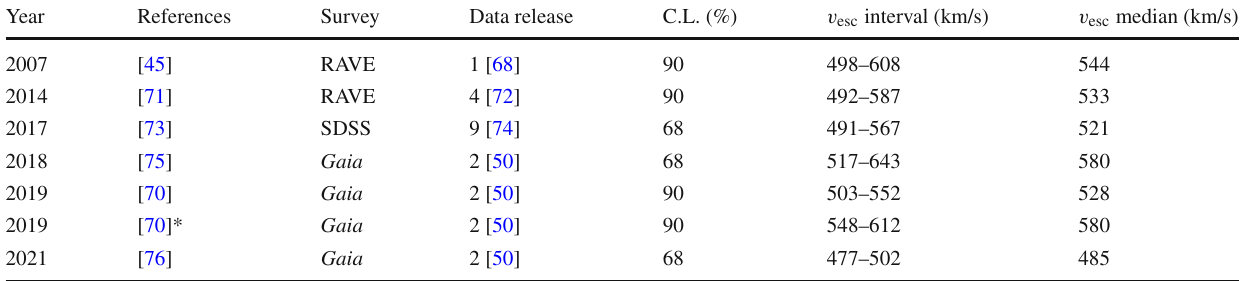
Table 2 Reported values of galactic escape speed. The measurement reported in [70]* is a re-analysis of the data set using the same priors used in